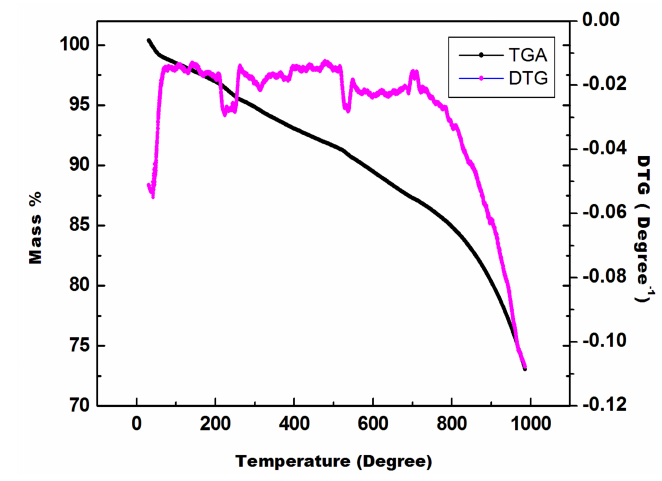
Figure 1. TG-DTG pattern of the S1